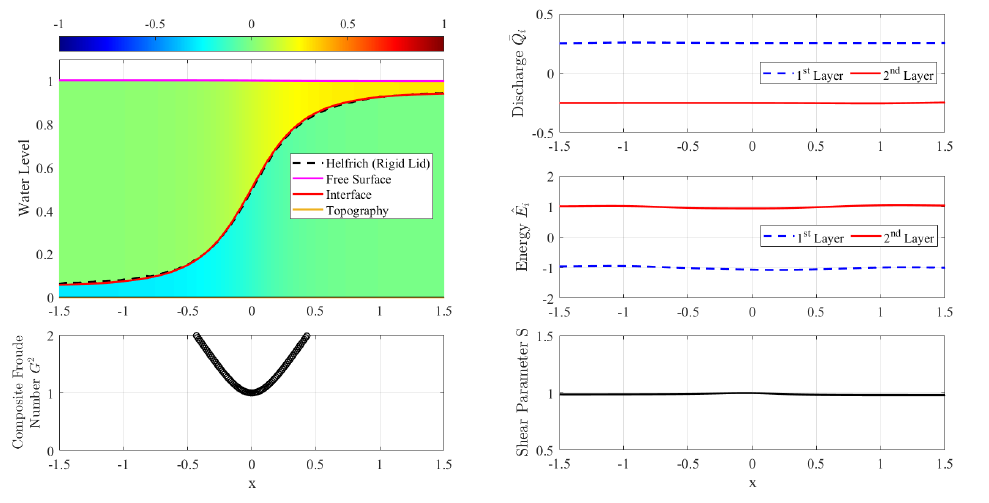
Figure 9. ( Left ) Steady interface in the case of maximal two layer exchange flow. The fluid velocity for each layer is represented by the color scale. ( Right ) Plots of discharge and energy for each layer, as well as a shear parameter with a value of one, indicating a conditional hyperbolicity based on